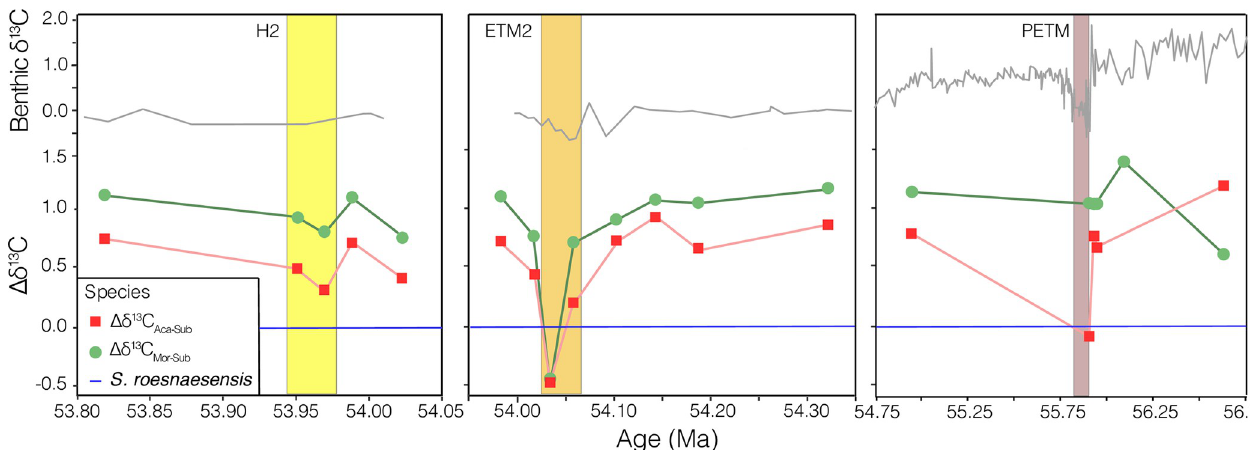
Fig 5. The Δδ 13 C of A . soldadoensis (red) and M . subbotinae (green), relative to that of S . roesnaesensis (blue) through time. Note different horizontal axes (time) across panels. The benthic δ 13 C record from [41] is shown in gray above, and the H2, ETM2, and PETM intervals are designated with yellow, orange, and brown shading